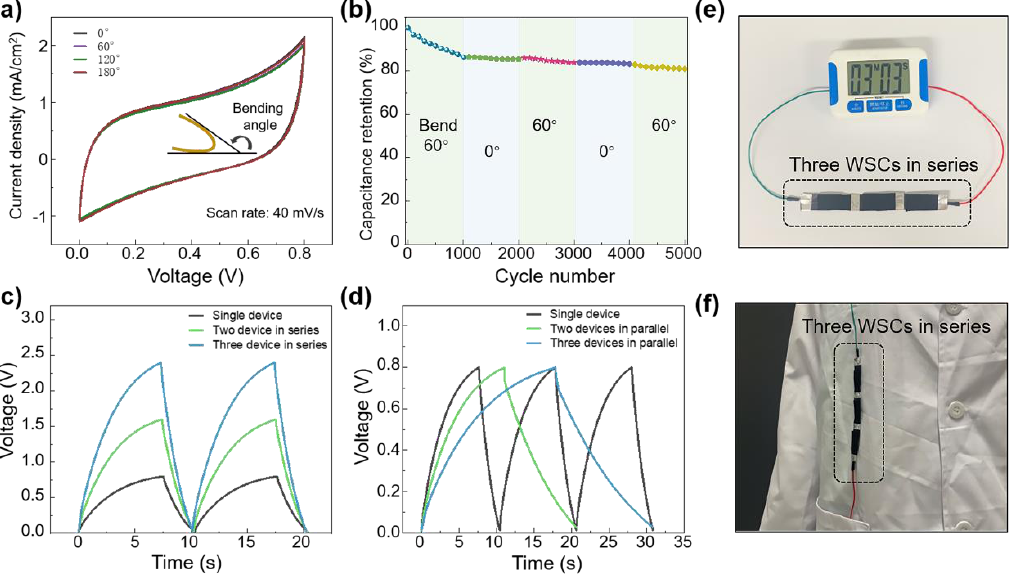
Figure 6. The electrochemical performance of the WSC with G/BNNS@H/KOH. ( a ) CV curves of the SC under different bending states obtained at a scan rate of 40 mV/s. ( b ) Cycling stability of WSCs with stage bending at a current density of 0.53 mA/cm 2 . ( c ) GCD curves of single/two/three WSCs connected in series. ( d ) GCD curves of single/two/three WSCs connected in parallel. ( e ) The timer powered by three WSCs linked in series. ( f ) The WSCs were anchored on cloth for powering the wearable electronic devices.